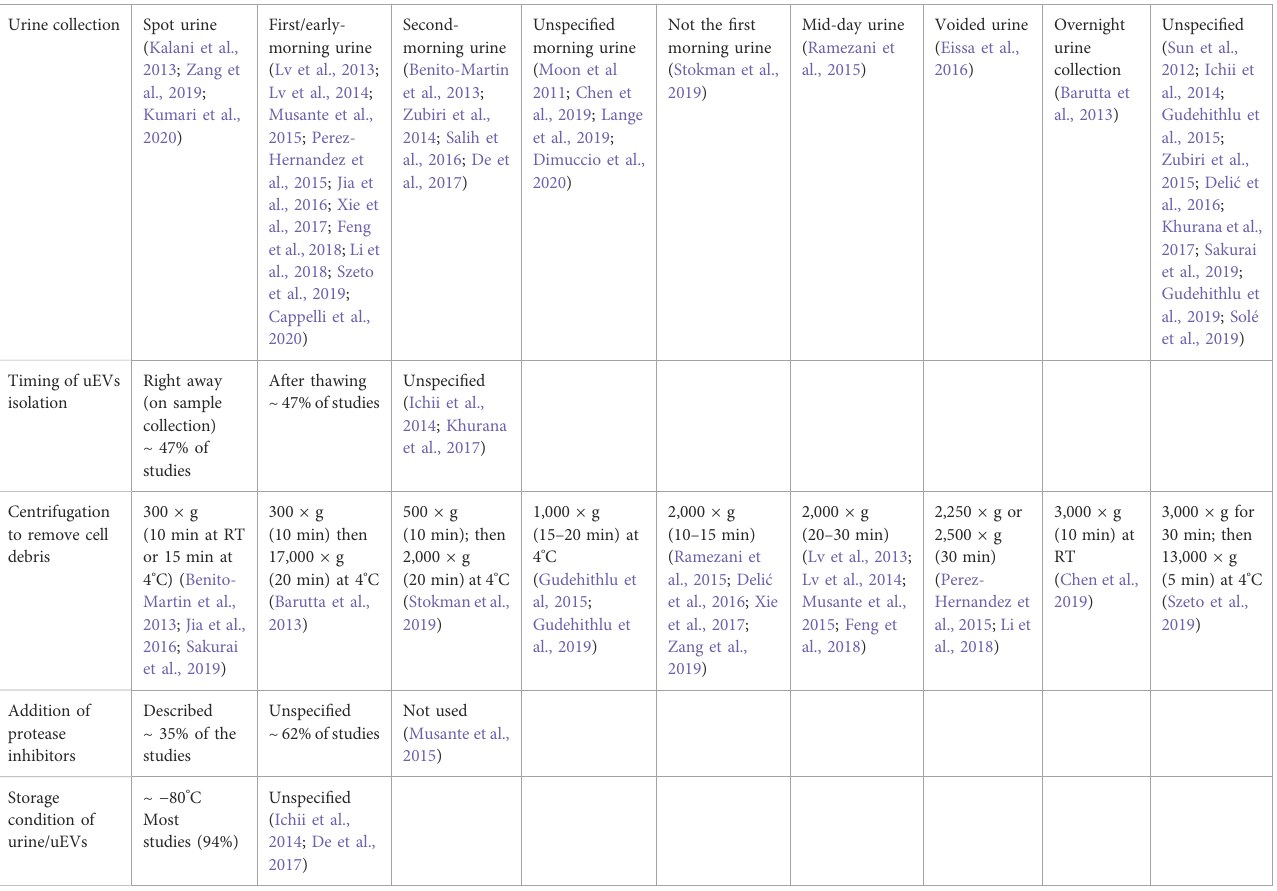
TABLE 5 Urine handling and storage conditions as reported in the studies included in this